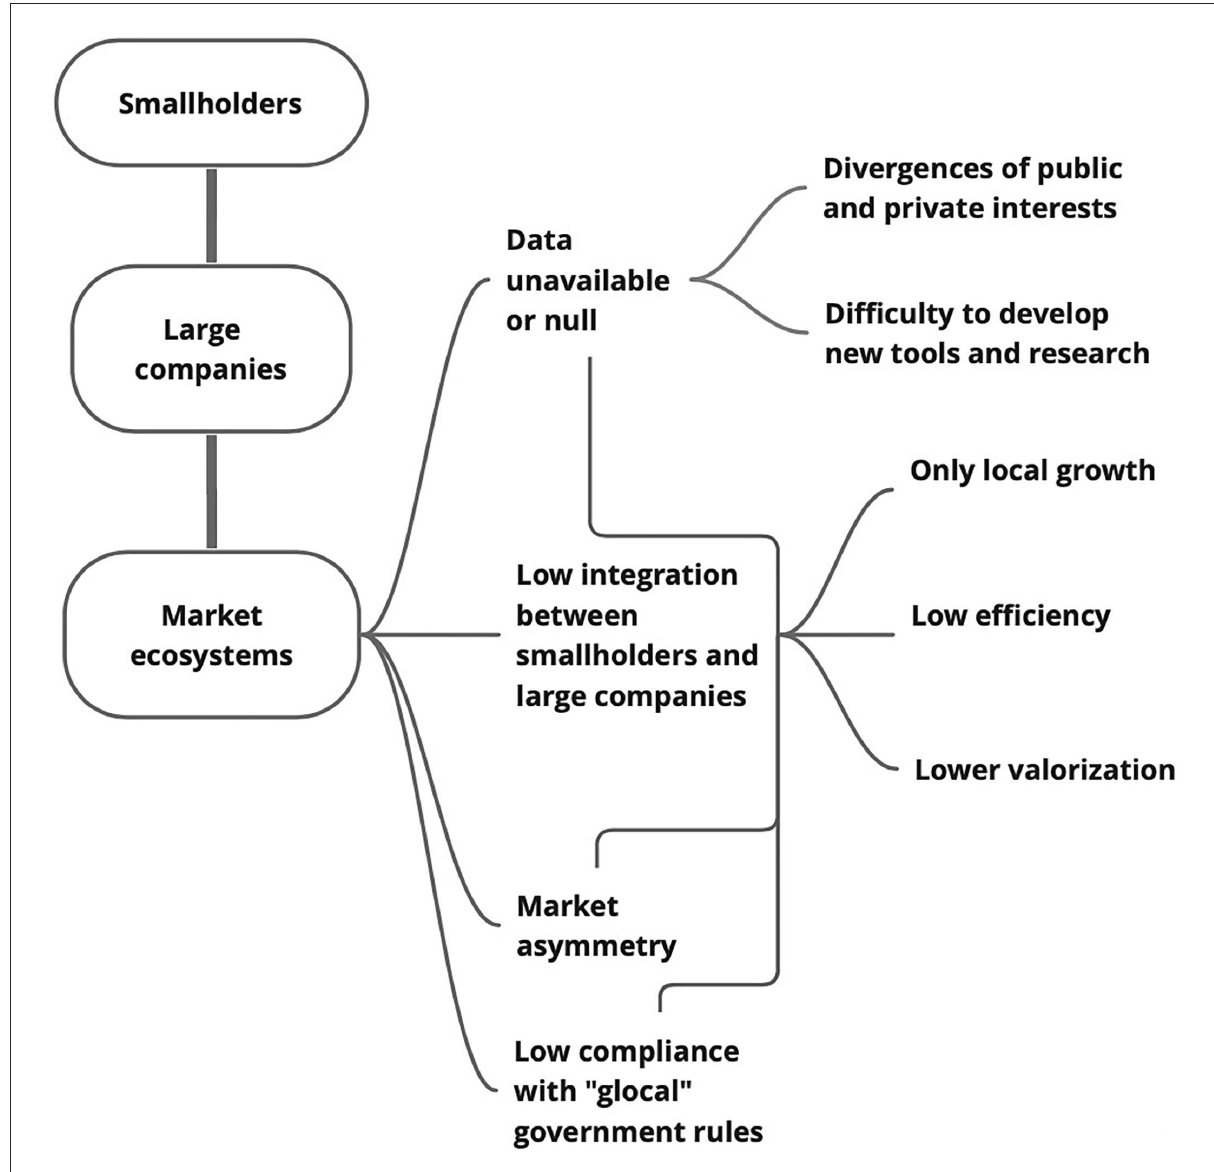
FIGURE2 Mental map of current smallholders access to the market ecosystem.